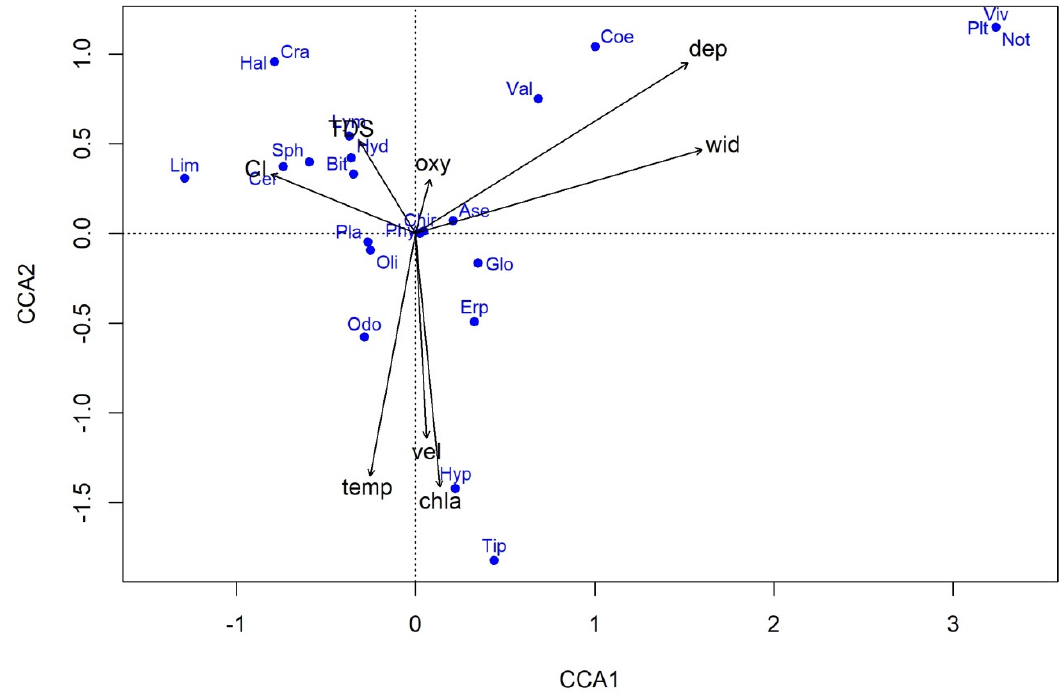
Figure 8. Macroinvertebrates taxa abundance among environmental factors in the Bukówka stream.